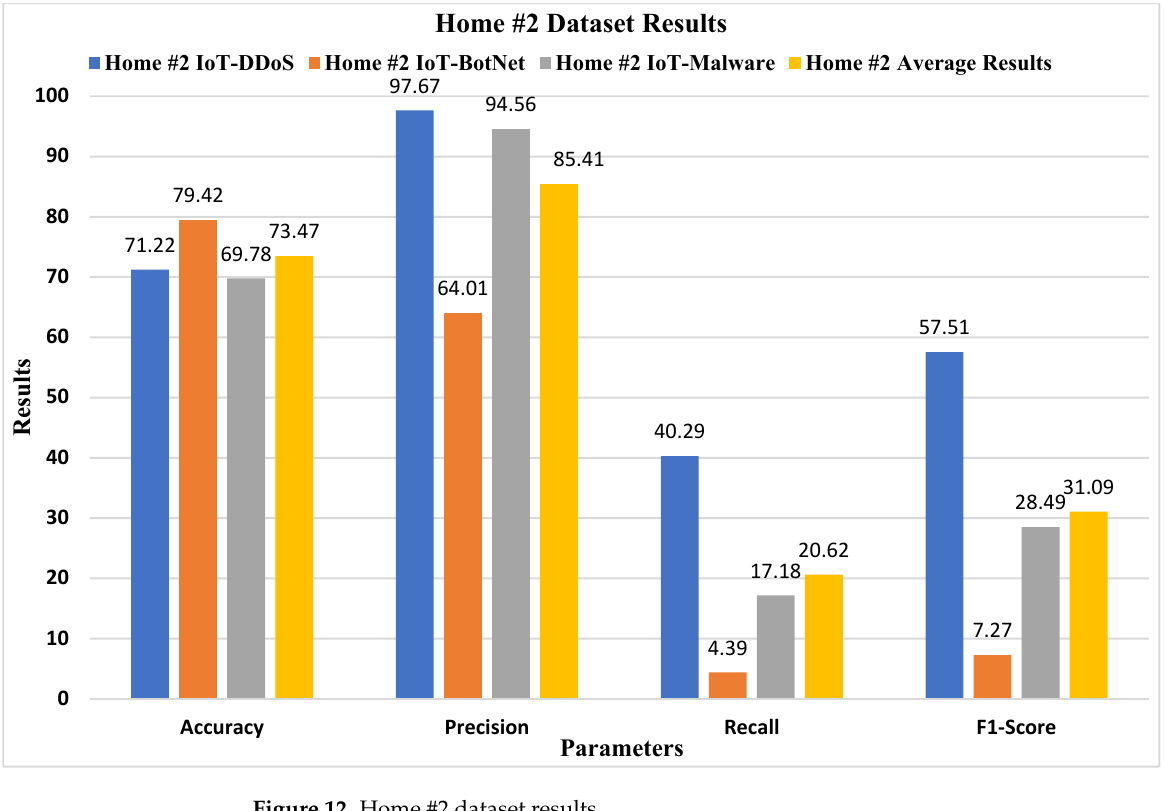
Figure 12. Home #2 dataset results.